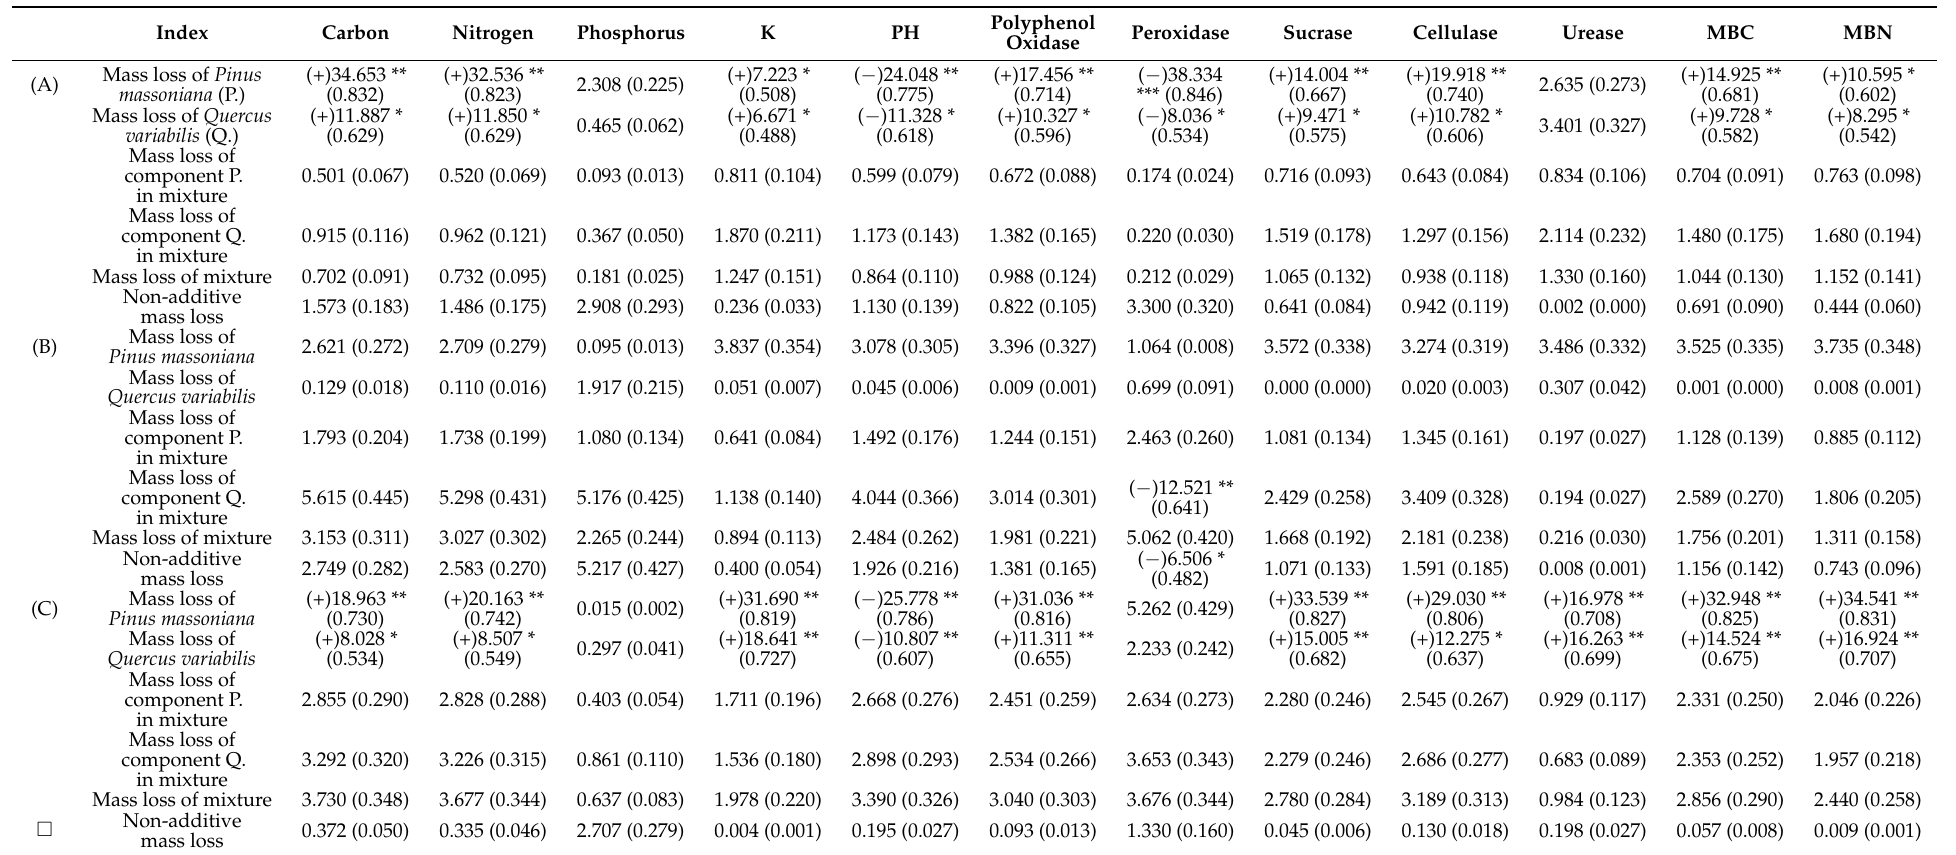
Table 2. Regression analyses of initial soil traits and litter mass loss rate or non-additive mass loss rate after one year (A), two years (B), and three years